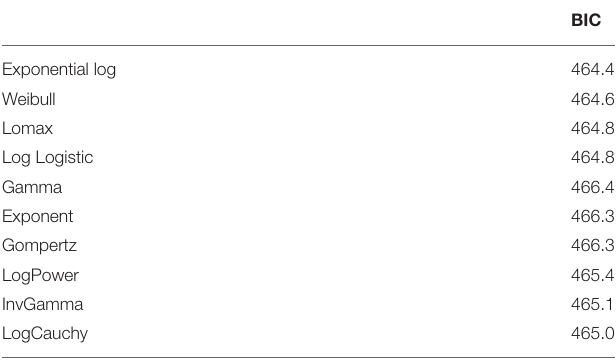
TABLE 3 | Survival curve-based analysis fit (BIC) for different time compression models.